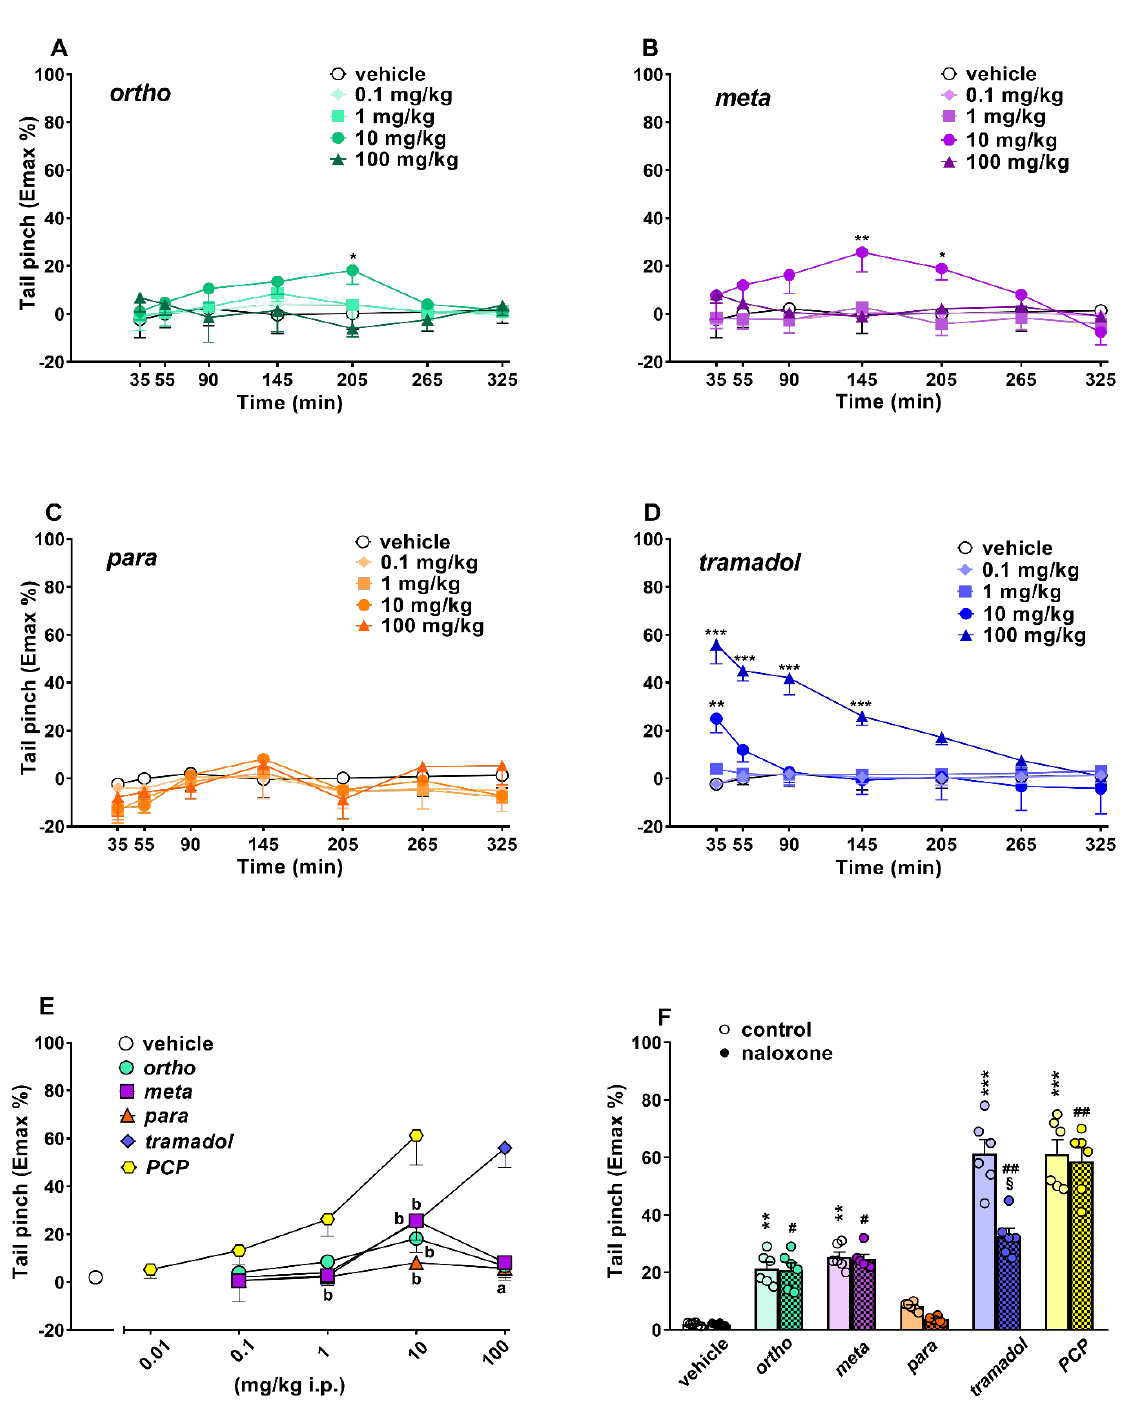
Figure 7. Effects of the systemic administration (0.1-100 mg/kg i.p.) of ortho ( A ), meta ( B ), para ( C ) and tramadol ( D ) on the tail pinch test in mice. Comparison of the maximal effect of ortho, meta, para, tramadol (0.1–100 mg/kg) and PCP (0.01–10 mg/kg) observed in 5 h ( E ) 2 . Interaction of the effects of ortho, meta, para, tramadol (100 mg/kg) and PCP (10 mg/kg) with the opioid receptor antagonist naloxone (6 mg/kg, i.p.; ( F )). Data are expressed as percentage of maximum effect (Emax%; see material and methods) and represent the mean ± SEM of 6–8 determinations for each treatment. Statistical analysis was performed by two-way ANOVA, followed by the Bonferroni’s test for multiple comparisons for the dose–response curve of each compound at different times ( A – D ), and for the antagonist studies ( E ), while the statistical analysis of panel F was performed with one-way ANOVA followed by Bonferroni test for multiple comparisons. * p < 0.05, ** p < 0.01, *** p < 0.001 versus vehicle; a p < 0.05 versus tramadol; b p < 0.05 versus PCP; # p < 0.05, ## p < 0.01 versus naloxone; § p < 0.05 versus without naloxone; 2 PCP data are elaborated from